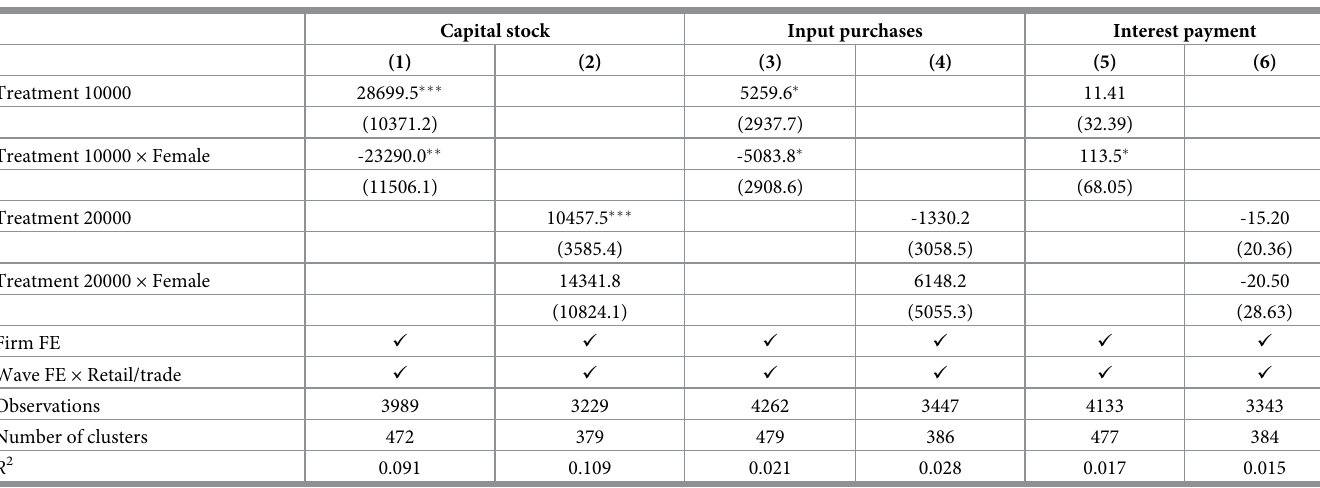
Table 7. Gender differences in business investment.